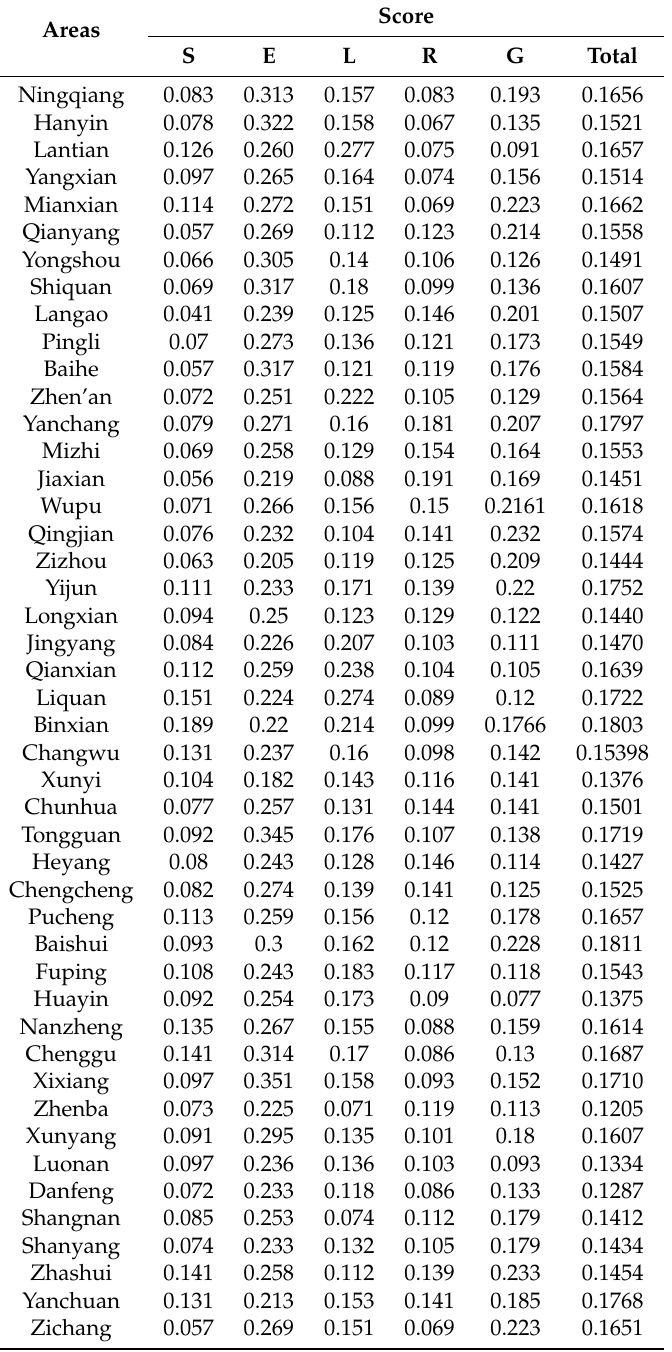
Table 6. Regional score of green development level very weak.